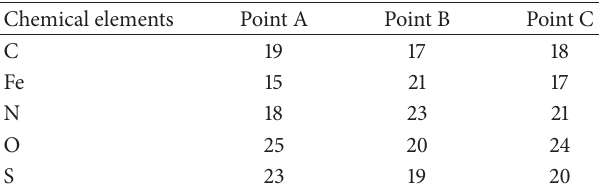
Table 1: Effect of RH, temperature, and SO 𝑋 in CR of SC in the cities evaluated for one month in winter in arid and semiarid zones.